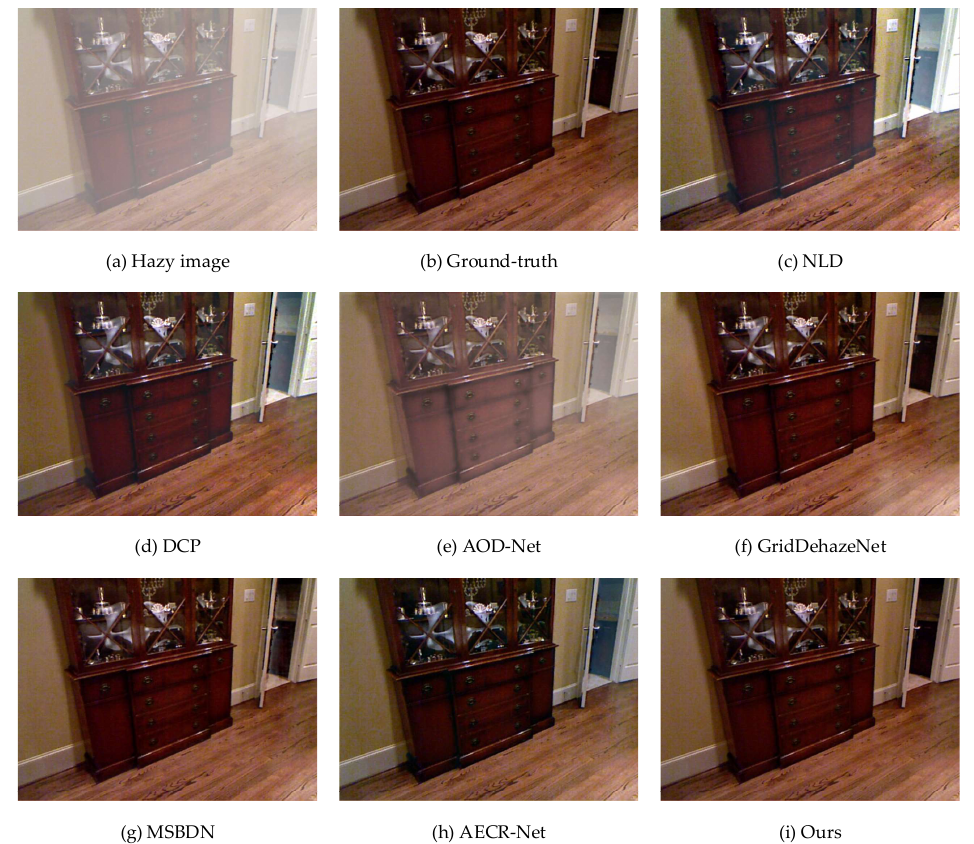
Figure 5. Visual quality comparison of SOTS dataset.